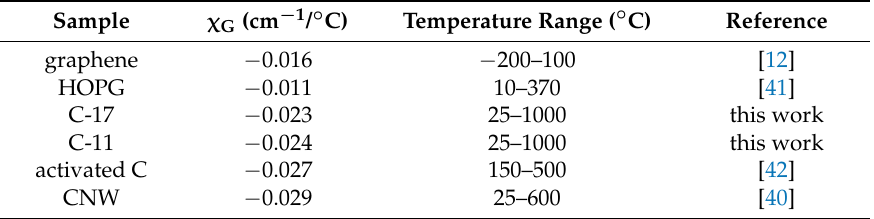
Table 1. Temperature coefficients of carbon-based